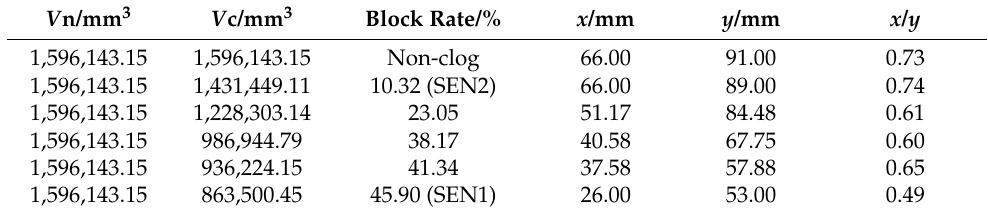
Figure 3. The geometry model in the flow region of SEN under the slag line with different block rates in front view and side view ( a1 , a2 ) non-clog, ( b1 , b2 ) 10.32%, ( c1 , c2 ) 23.05%, ( d1 , d2 ) 38.17%, ( e1 , e2 ) 41.34%, ( f1 , f2 ) 45.9%. Table 1. The geometry information for the SEN in the flow region.